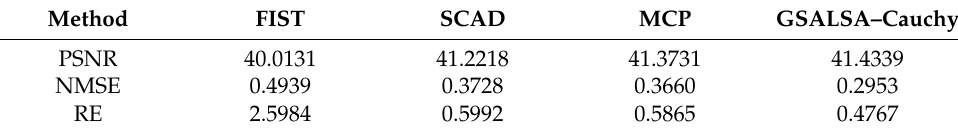
Table 9. PSNR, NMSE and RE of aircraft model under 25% sampling.